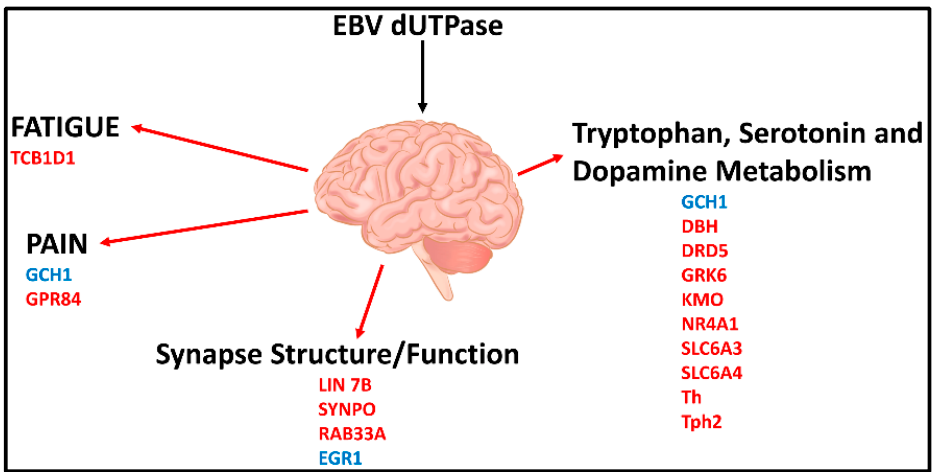
Figure 3. Effects of EBV dUTPase on gene expression in brains of female C57Bl/6 mice (6–8 weeks old) and the potential neurological circuits modulated with direct implications in ME/CFS. Genes in blue were significantly upregulated while those in red were significantly downregulated [120].